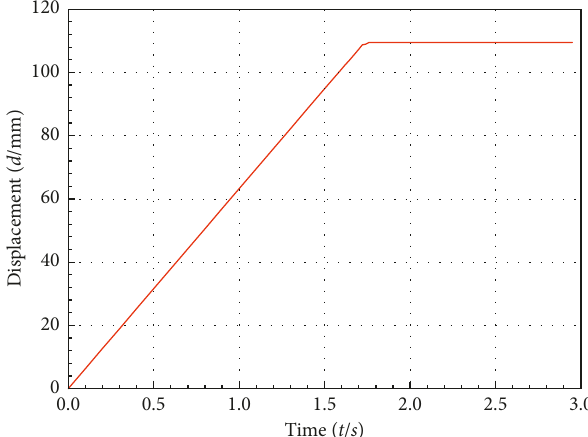
Figure 9: Cosimulation result of spring compression from AMESim.